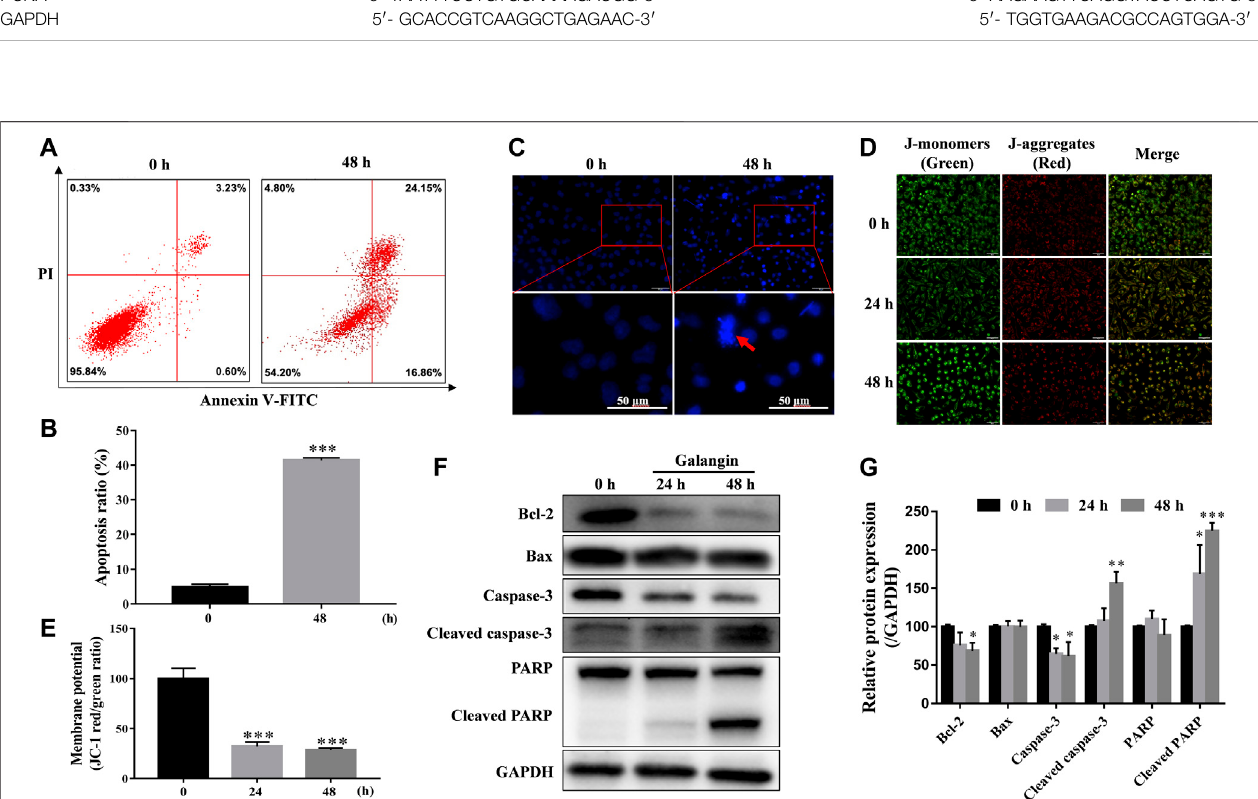
FIGURE 2 | Galangin promotes cell apoptosis. (A – B) Glangin enhanced cell apoptosis after treatment for 24 h in MGC 803 cells detected by Annexin V-FITC/PI staining. (C) Galangin (20 μ M) induced chromatin condensation and nuclear shrinkage or fragmentation in MGC 803 cells after 48 h treatment stained with Hoechst 33,258. (D – E) Galangin (20 μ M) treatment decreased mitochondrial membrane potential (MMP) in MGC 803 cells after treatment for 24 and 48 h, detected by JC-1 (10 μ M)staining.ThestainingofMGC803cellsbyJC-1isvisibleasgreenforJ-monomers(emissionmaximumof ∼ 529 nm)orredforJ-aggregates(withaspeci fi c red fl uorescence emission maximum at 590 nm). (F – G) Galangin (20 μ M) modulated protein expression of apoptosis-related proteins in MGC 803 cells after treatment for 24 and 48 h analyzed by Western blotting analysis. All of the data were shown as mean ± SD, and differences among two groups ( Figure 2B ) were analyzed by